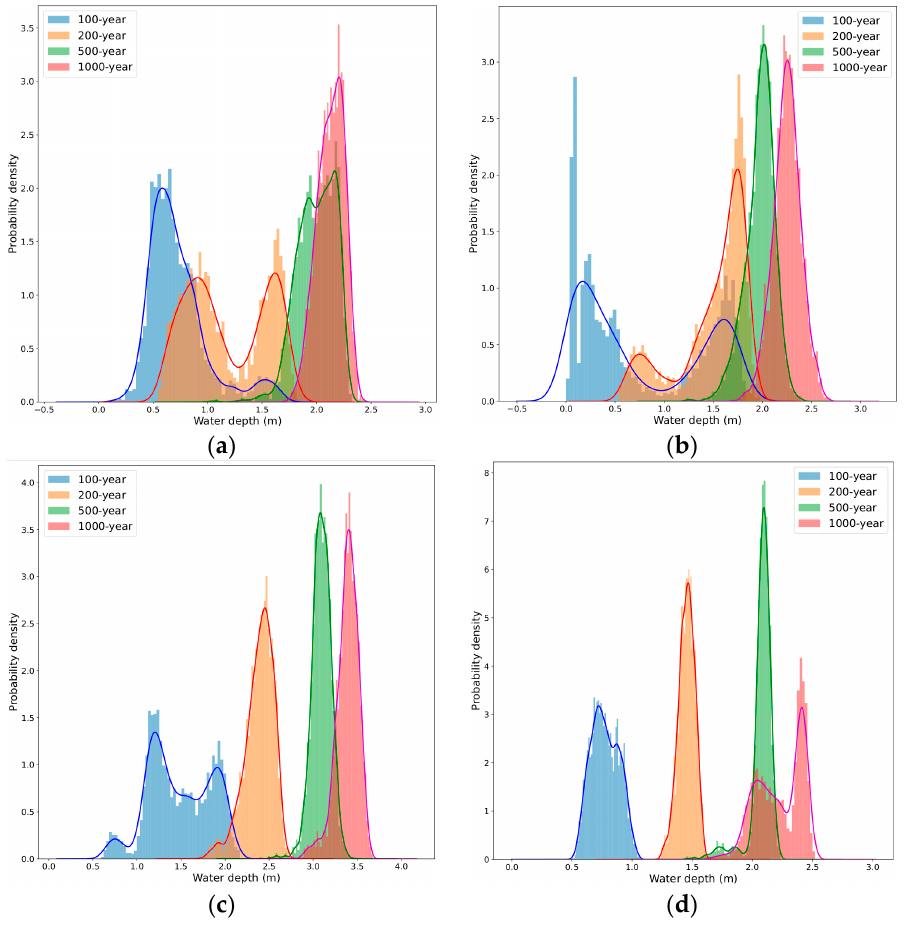
Figure 8. Water level probability density function estimated with Monte-Carlo sampling for 100, 200, 500 and 1000-year return period floods at control points: ( a ) Sully-Sur-Loire; ( b ) Les Places; ( c ) Les Boutrons; ( d ) Le Mesnil.